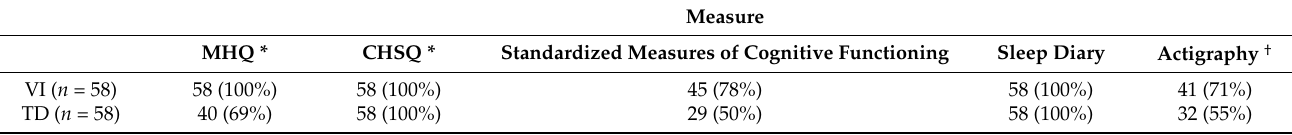
Table 2. Response rate to measures according to group.